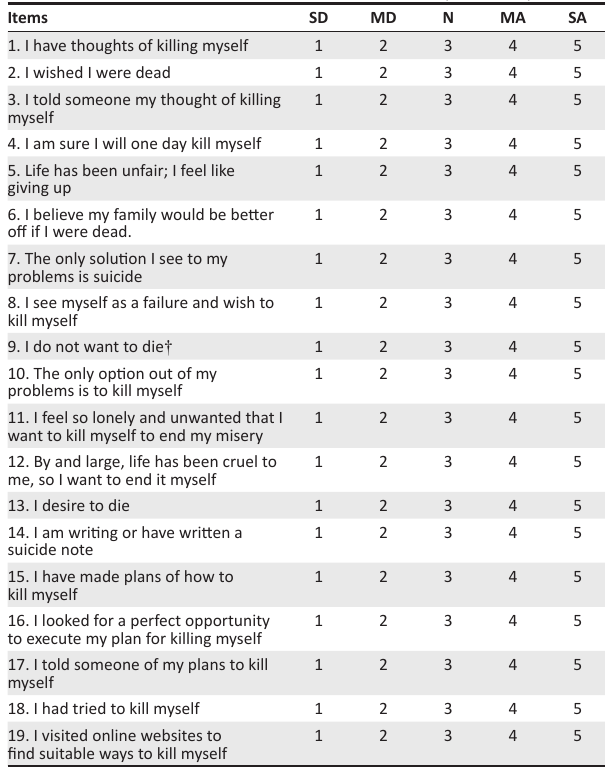
TABLE 6: The final draft of validated Redeemer’s University Suicidality Scale. Items